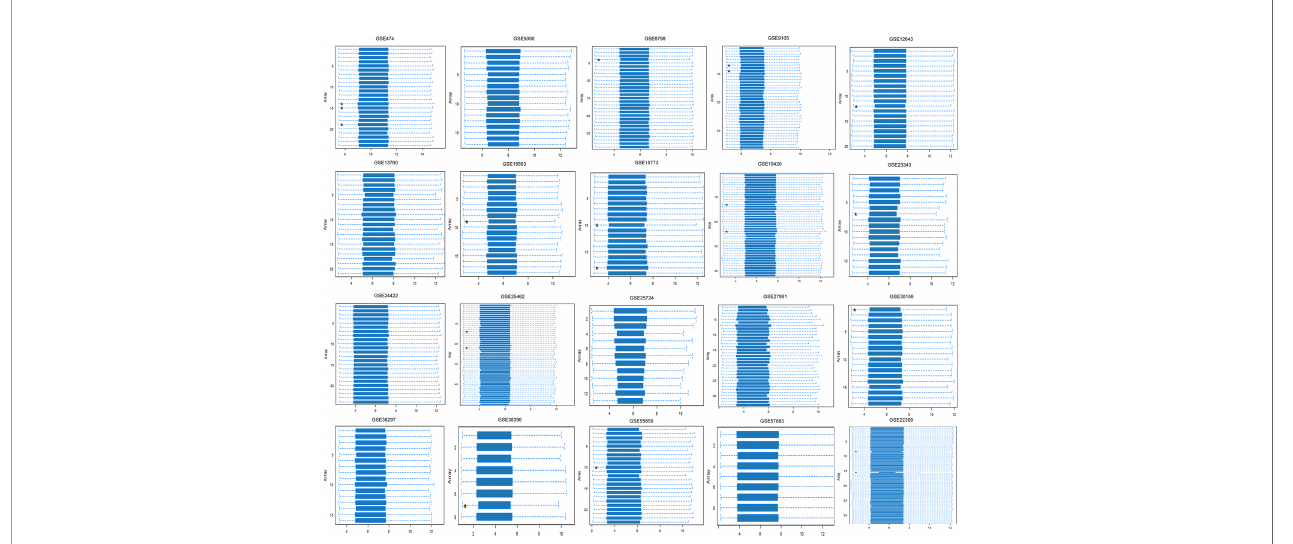
FIGURE 1 | Array intensity distributions showing boxplots representing summaries of the signal intensity distributions of the arrays and normalization with similar positions and widths. Each box corresponds to one array. Outlier detection was performed by computing the Kolmogorov – Smirnov K a statistic between each distribution of the array and the distribution of the pooled